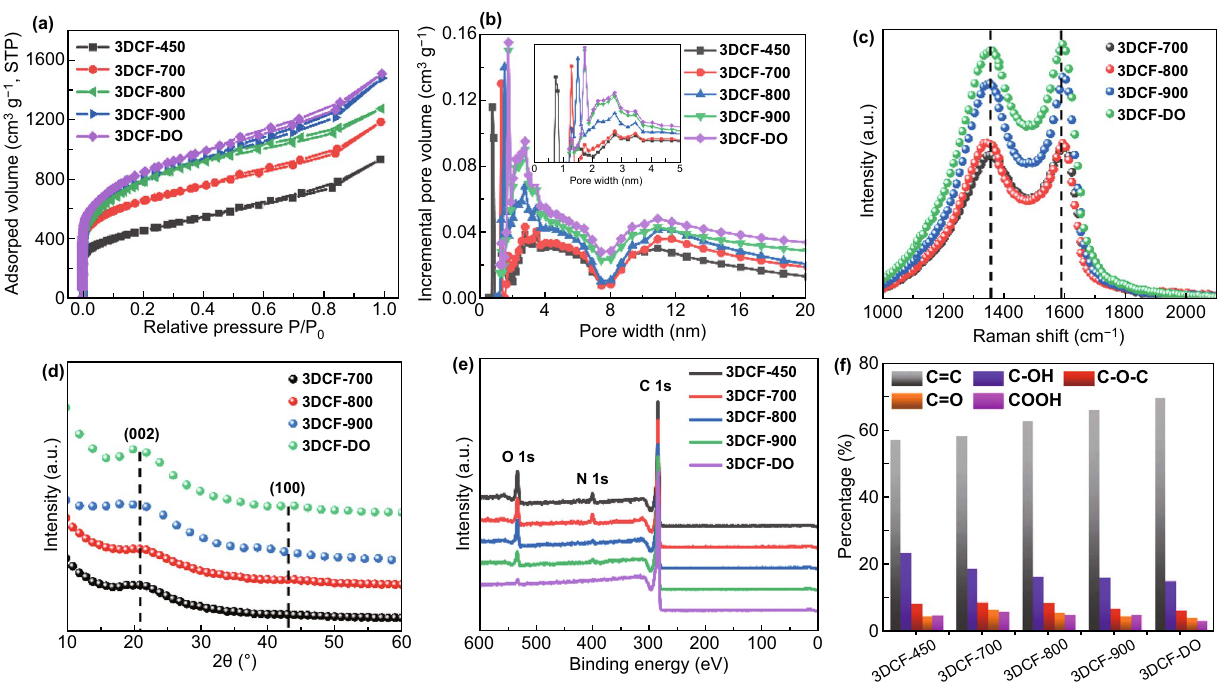
Fig. 2 a N 2 adsorption and desorption isotherms, b corresponding pore size distributions, c Raman spectra, d powder XRD patterns, e survey spectra and f C 1 s deconvoluted spectra of 3DCF